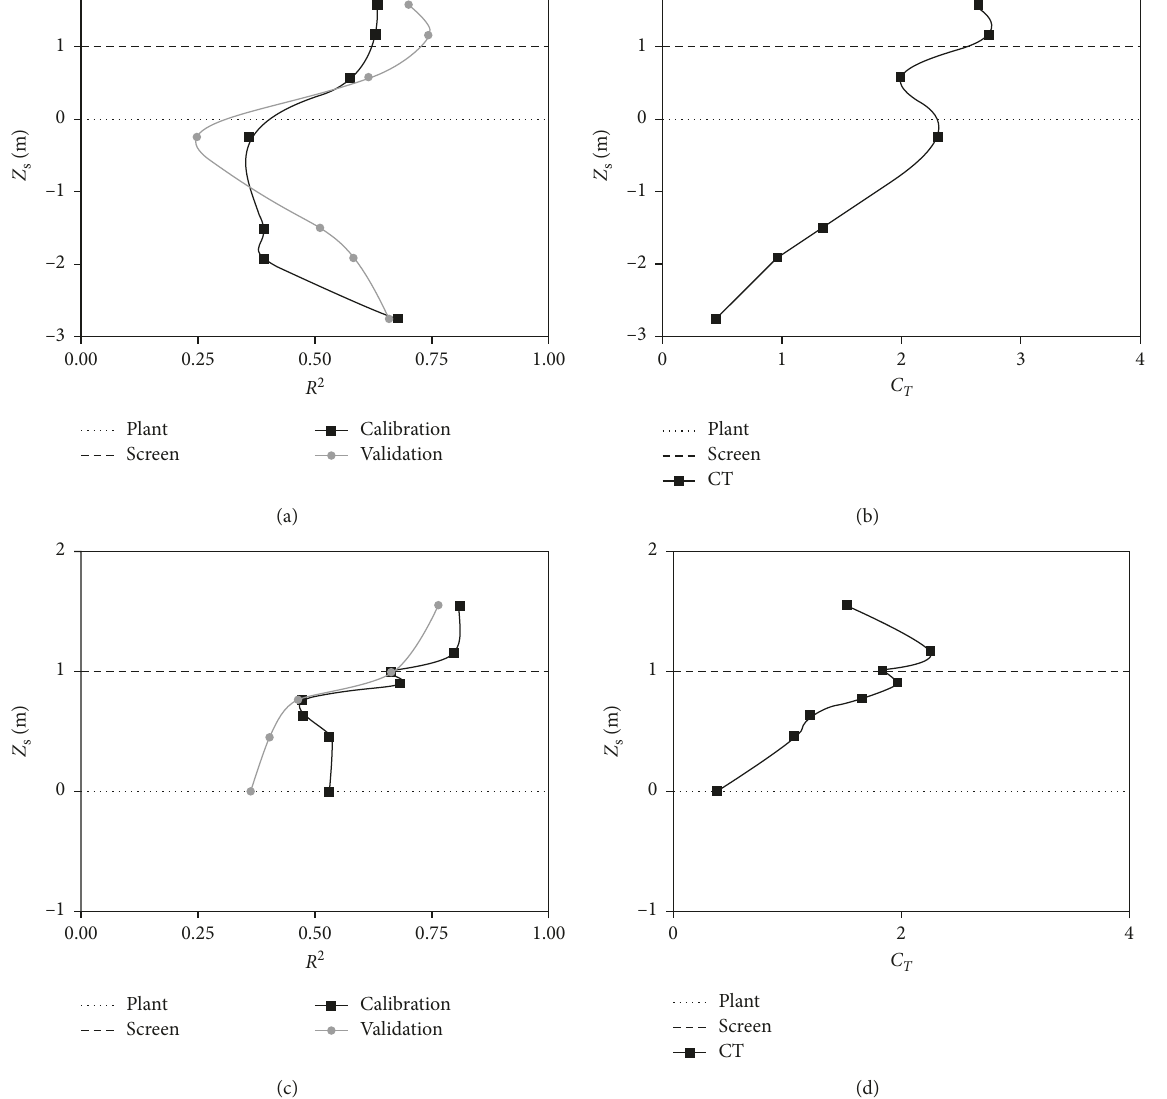
0, canopy top; Z S 1 screen height. (cid:31) (cid:31)